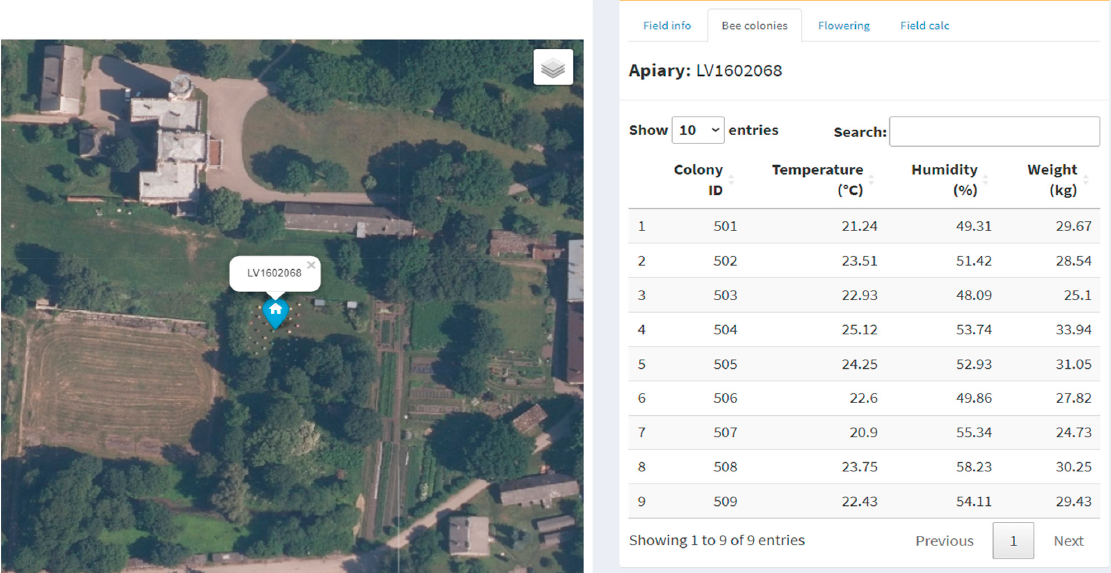
Figure 3. Bee colony monitoring data within application.